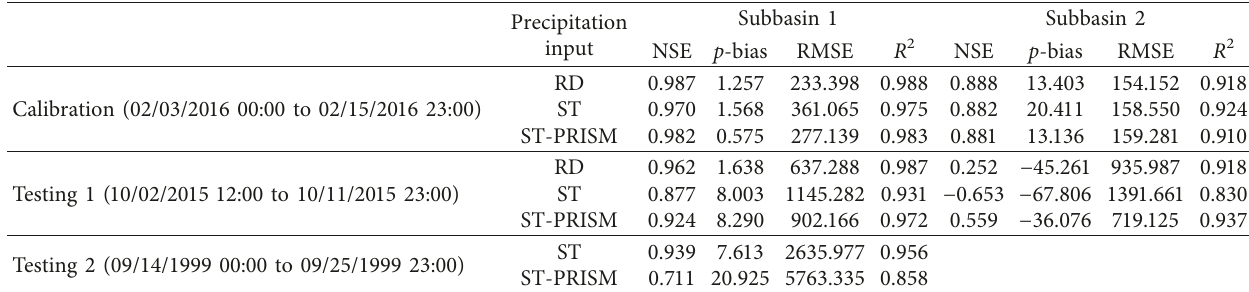
Table 5: Model performance in the Waccamaw watershed.